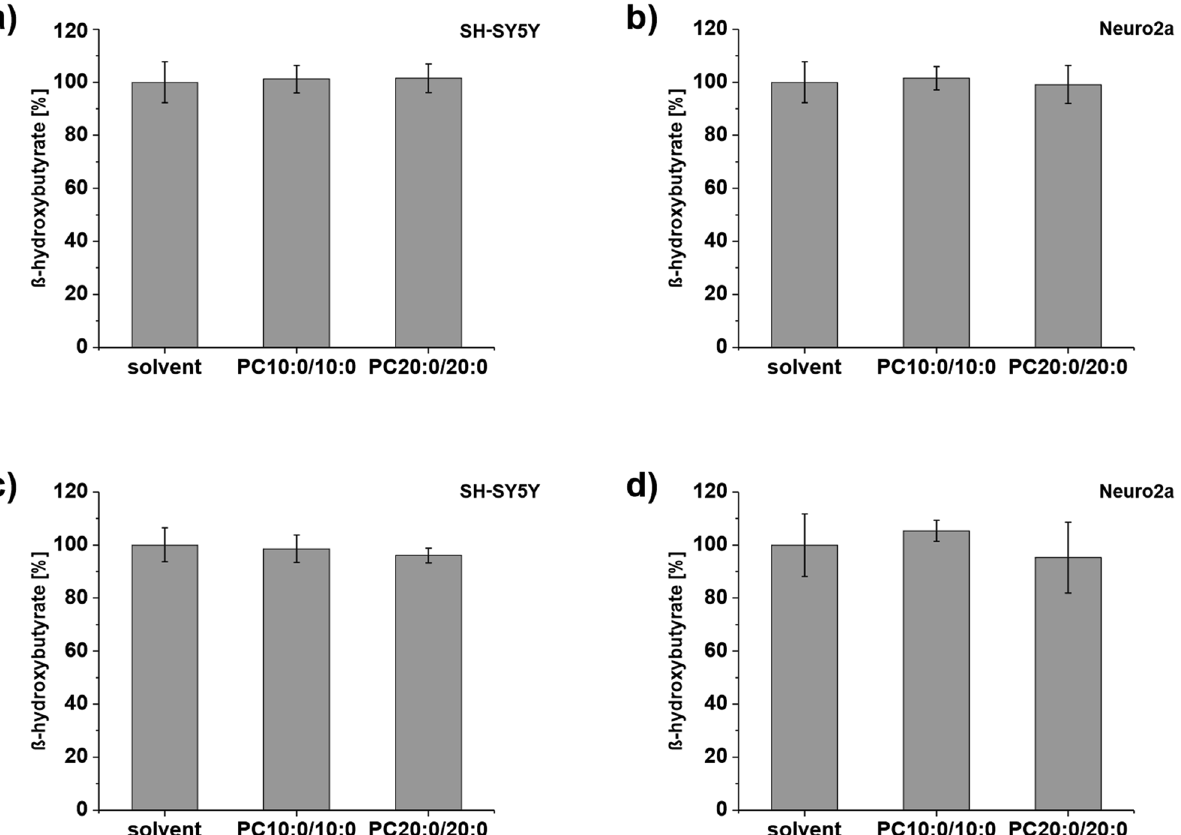
Figure 3. Impact of PC10:0/10:0, PC20:0/20:0 or solvent on the intra- and extracellular βHB level. Cells were incubated with the solvent EtOH (0.2%) (set as 100%), PC10:0/10:0 or PC20:0/20:0 (10 µM) for 18 h before the level of βHB was measured by using the β-Hydroxybutyrate (Ketone Body) Colorimetric Assay Kit. βHB level in the homogenates of ( a) SH-SY5Y cells (n = 8) and ( b) Neuro2a cells (n ≥ 5). βHB level in the conditioned medium of ( c) SH-SY5Y cells (n = 8) and ( d) Neuro2a cells (n ≥ 5). Error bars represent SD. The statistical significance was calculated by one-way ANOVA followed by post hoc testing using Tukey’s test, no significant differences were observed. Figure was created using Origin Pro 2020b and CorelDRAW Graphics Suite